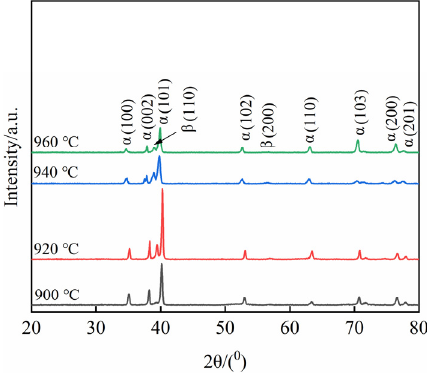
Figure 9. XRD diffraction patterns after BASCA heat treatment.